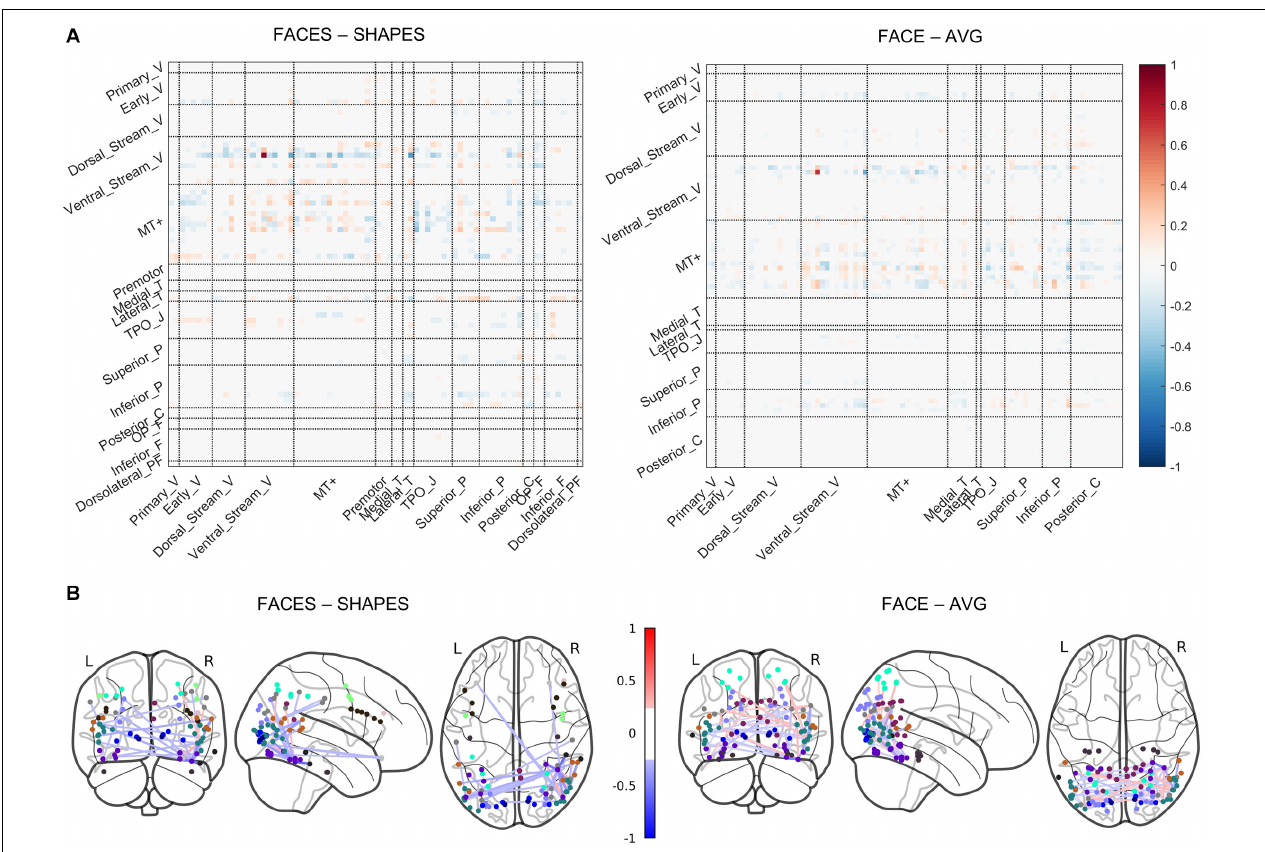
FIGURE 4 | Visualization of the propagation coefficient involving rFFC’s face function. The propagation coefficient W in the first layer of the network is shown. (A) The coefficients are shown in a matrix plot. Color represents the coefficient strength of each connection. Brain regions that belong to the same cortex are grouped. Full names of cortices are included in Supplementary Table S2 . (B) The coefficients are plotted on the glass brain. Only the connection with the top 1% coefficient strength is shown to make the plot clean. Edge color represents the coefficient strength of each connection. Node color represents the cortices that each brain region belongs to (see Supplementary Figure S1